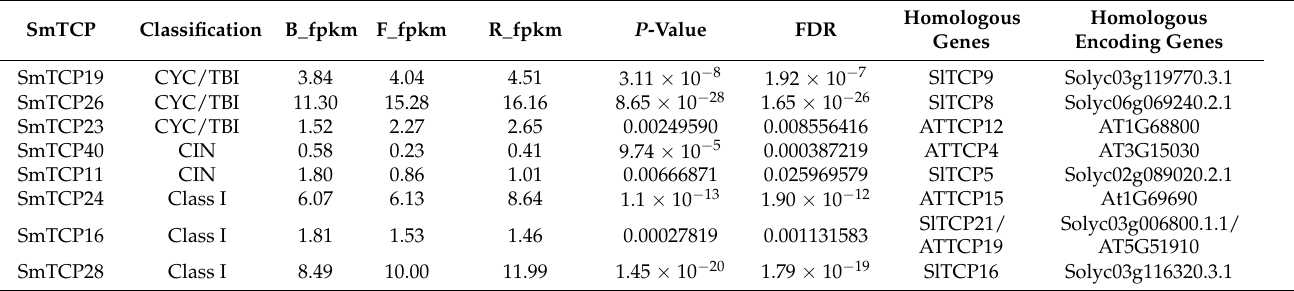
genes of S. muricatum